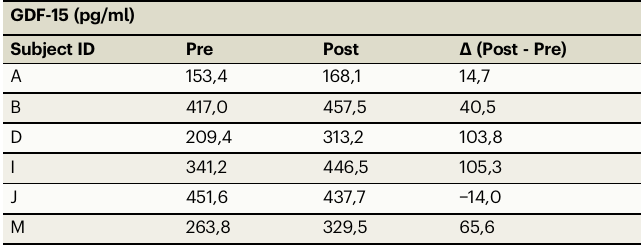
Table 2 | GDF-15 blood levels in individuals before (pre) and after (post) an exercise on a bicycle ergometer at 60% VO2 peak for